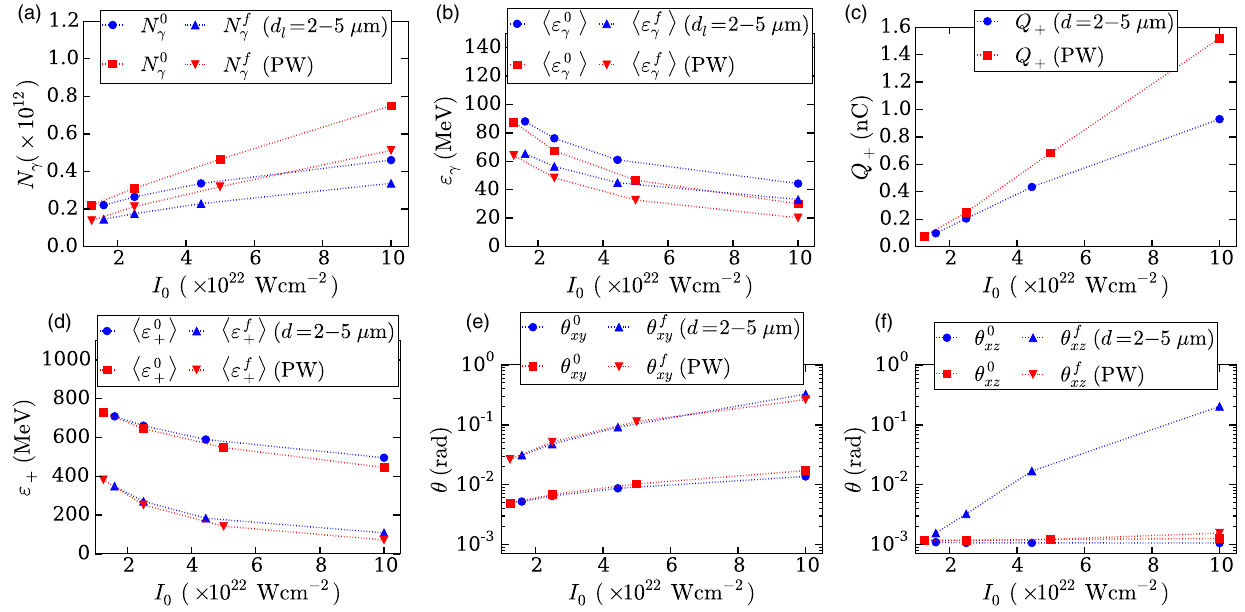
FIG. 10. Laser intensity dependence of the total number of γ -rays (of energies > 2 m e c 2 ), N γ (a), average γ -ray energy, h ε γ i (b), total positron charge Q þ (c), average positron energy, h ε þ i (d), angular spread in the polarization plane, θ xy (e), and in the perpendicular plane, θ xz (e). The superscripts 0 and f denote quantities measured at creation time and at the end of the interaction, respectively, while the blue and red markers correspond to focused laser waves (of various spot sizes) and planar waves